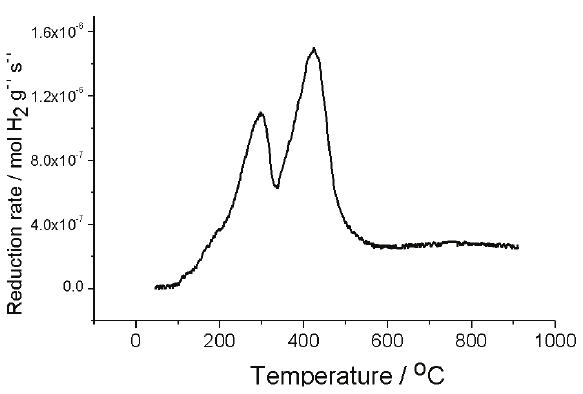
Zr O sample. 0.5 0.5 2